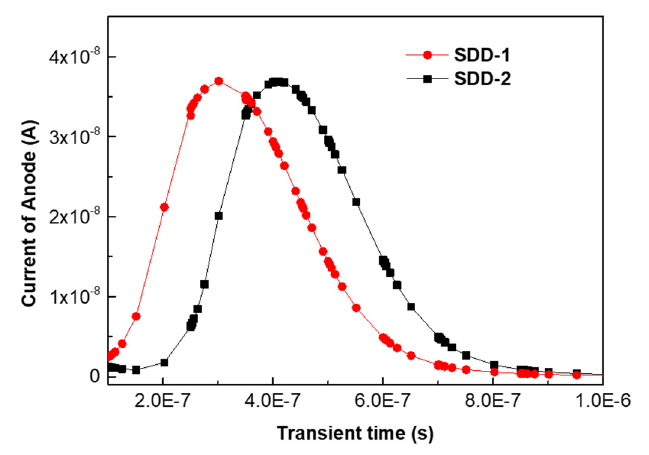
Figure 4. The simulation of the anode current of SDD-1 and SDD-2 versus the time for collecting electrons. In the simulation, E (the energy of incoming radiation) is 5 Mev and t (the time of collecting electrons) is 0 to 1 × 10 − 6 s.